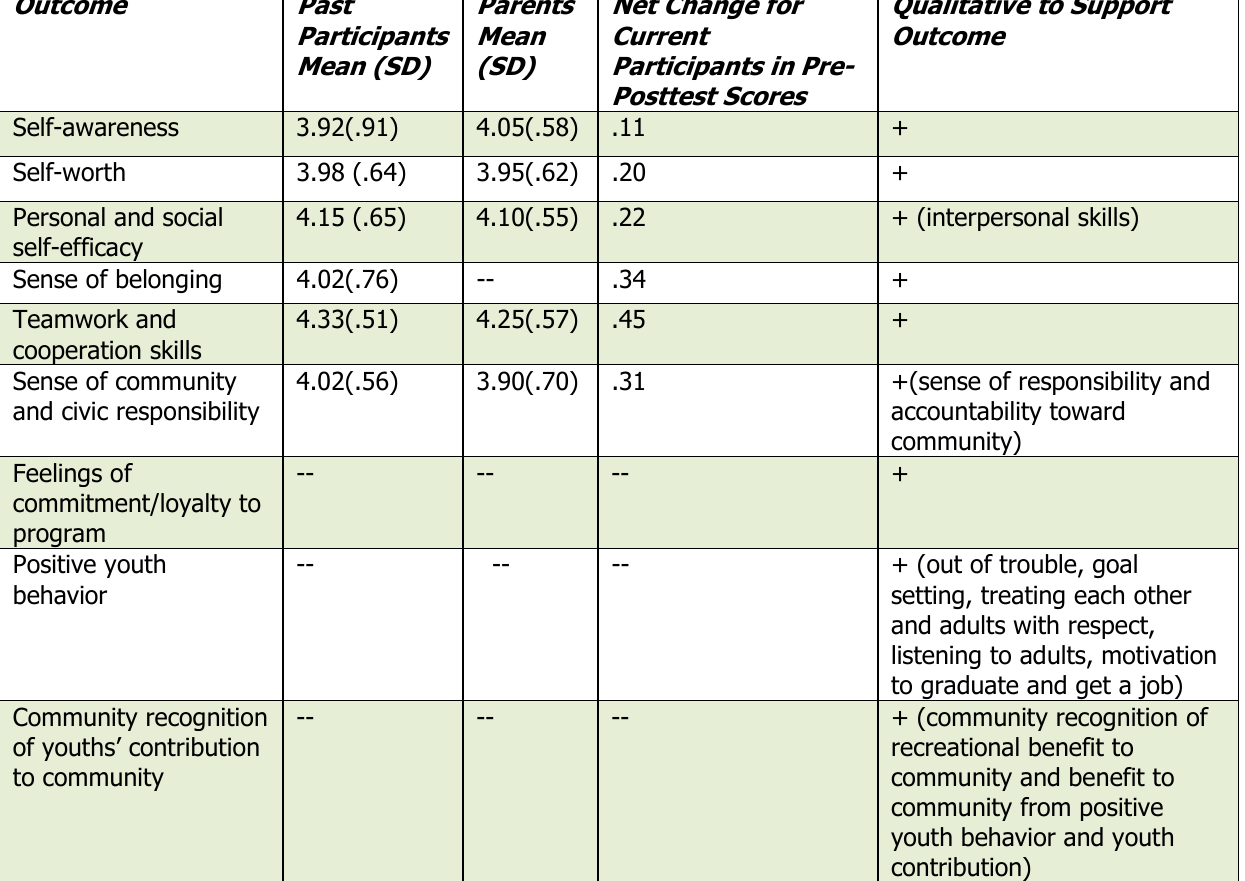
Integration of Quantitative and Qualitative